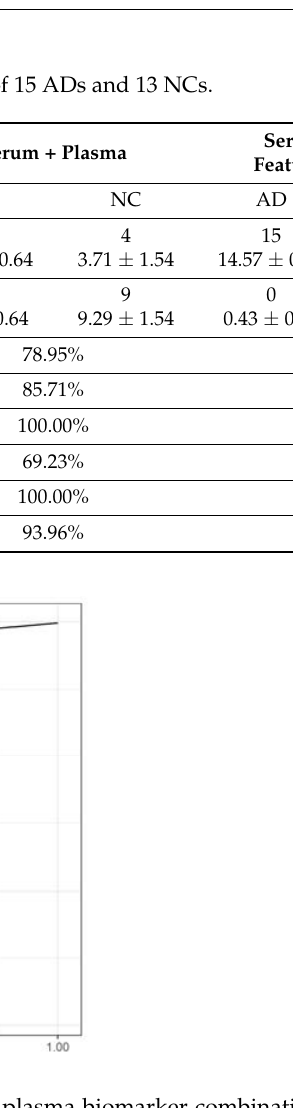
Table 4. Average performance for the testing set of 15 ADs and 13 NCs.